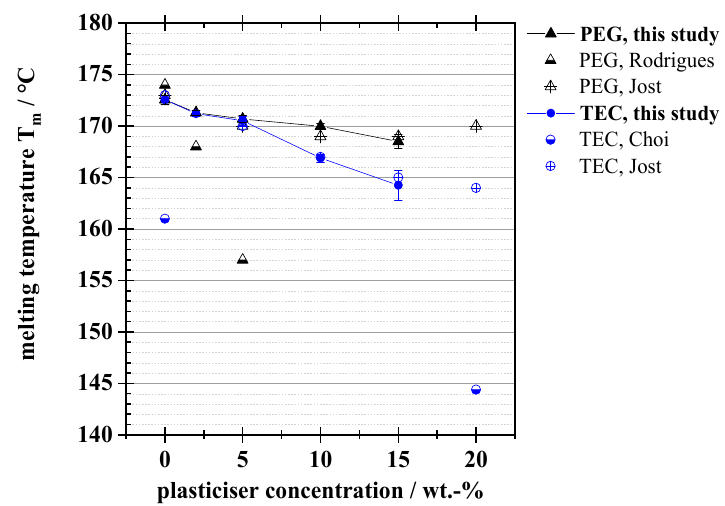
Figure 1. Melting temperatures of poly(3-hydroxybutyrate-co-3-hydroxyvalerate) (PHBV) and PHBV with different concentrations of plasticizers. PEG: polyethylene glycol, TEC: triethyl citrate.